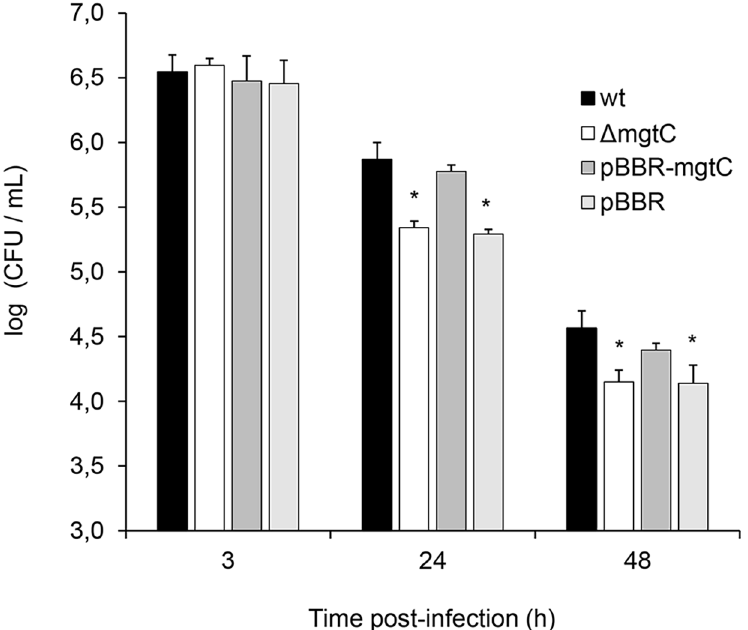
Fig 2. MgtC is required for intracellular survival. Wild type B . pertussis (wt), B . pertussismgtC deficient mutant ( Δ mgtC ), B . pertussismgtC deficient mutant carrying the pBBR1MCS vector (pBBR), and B . pertussismgtC deficient mutant carrying a pBBR1MCS derivative that encodes mgtC (pBBR- mgtC ) were incubated with THP-1 macrophages (MOI: 100) for 2 h at 37˚C, washed, and further incubated with polymyxin B to kill the extracellular bacteria. The number of CFU was determined at 3, 24, and 48 hours post-infection. The means ± SD of triplicates of one representative experiment out of three performed are given. The number of CFU per mL of Δ mgtC and pBBR at 24 and 48 h post-infection was significantly different from the number of CFU per mL of the wt and pBBR- mgtC strains at the respective time post-infection. Statistical significance analysis was performed using one-way ANOVA ( (cid:3) P < 0.05).